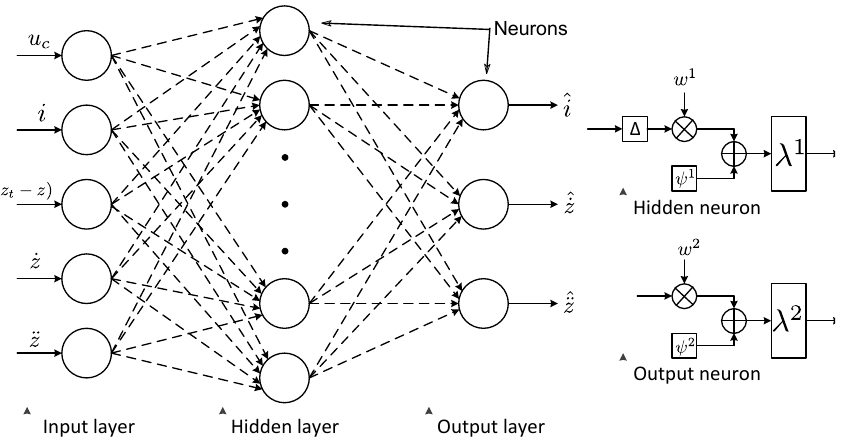
Figure 5. The Neural network architecture for the i FD as applied on the